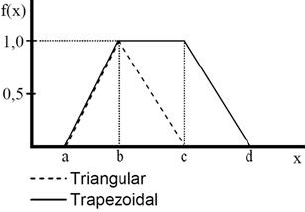
Figure 1. Graph to show the characteristic of triangular and trapezoidal fuzzy number [36].